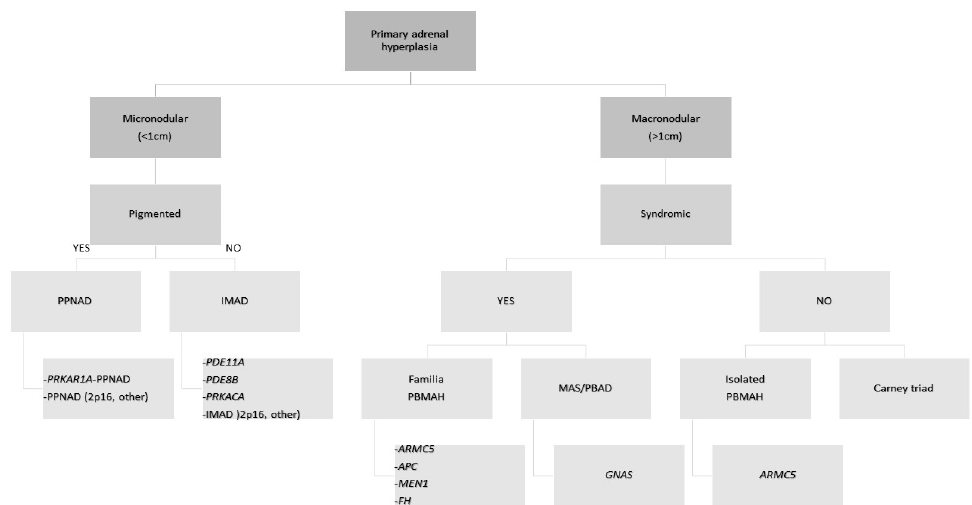
Figure 1. Algorithm for the diagnosis of primary cortisol-producing adrenocortical hyperplasias based on the underlying genetic etiology. APC adenomatous polyposis coli gene , ARMC5 armadillo repeat-containing protein 5, c-PPNAD CNC-associated primary pigmented nodular adrenocortical disease, CNC Carney complex, FH fumarate hydratase, GNAS gene coding for the stimulatory sub- unit α of the G-protein (Gs α ), i-MAD isolated micronodular adrenocortical disease, i-PPNAD iso- lated PPNAD, MAS McCune–Albright syndrome, MEN1 multiple endocrine neoplasia type 1, PBAD primary bimorphic adrenocortical disease, PBMAH primary bilateral macronodular adreno- cortical hyperplasia, PDE8B phosphodiesterase 8B gene, PDE11A phosphodiesterase 11A gene, PPNAD primary pigmented nodular adrenocortical disease, PRKACA protein kinase cAMP-de- pendent catalytic, alpha, PRKAR1A protein kinase cAMP-dependent regulatory type I α gene. Adapted from Kamilaris CDC, Stratakis CA, Hannah-Shmouni F, 2020 [23]. The cAMP/protein kinase A (PKA) pathway plays a vital role in adrenocortical cell development, proliferation, and function. Normally, in adrenocortical cells, the pathway is activated by the adrenocorticotropic hormone (ACTH) that binds to its 7-transmem- brane G protein-coupled receptor MC2R which activates Gs protein; that further increases cAMP levels and activated PKA (Figure 2).